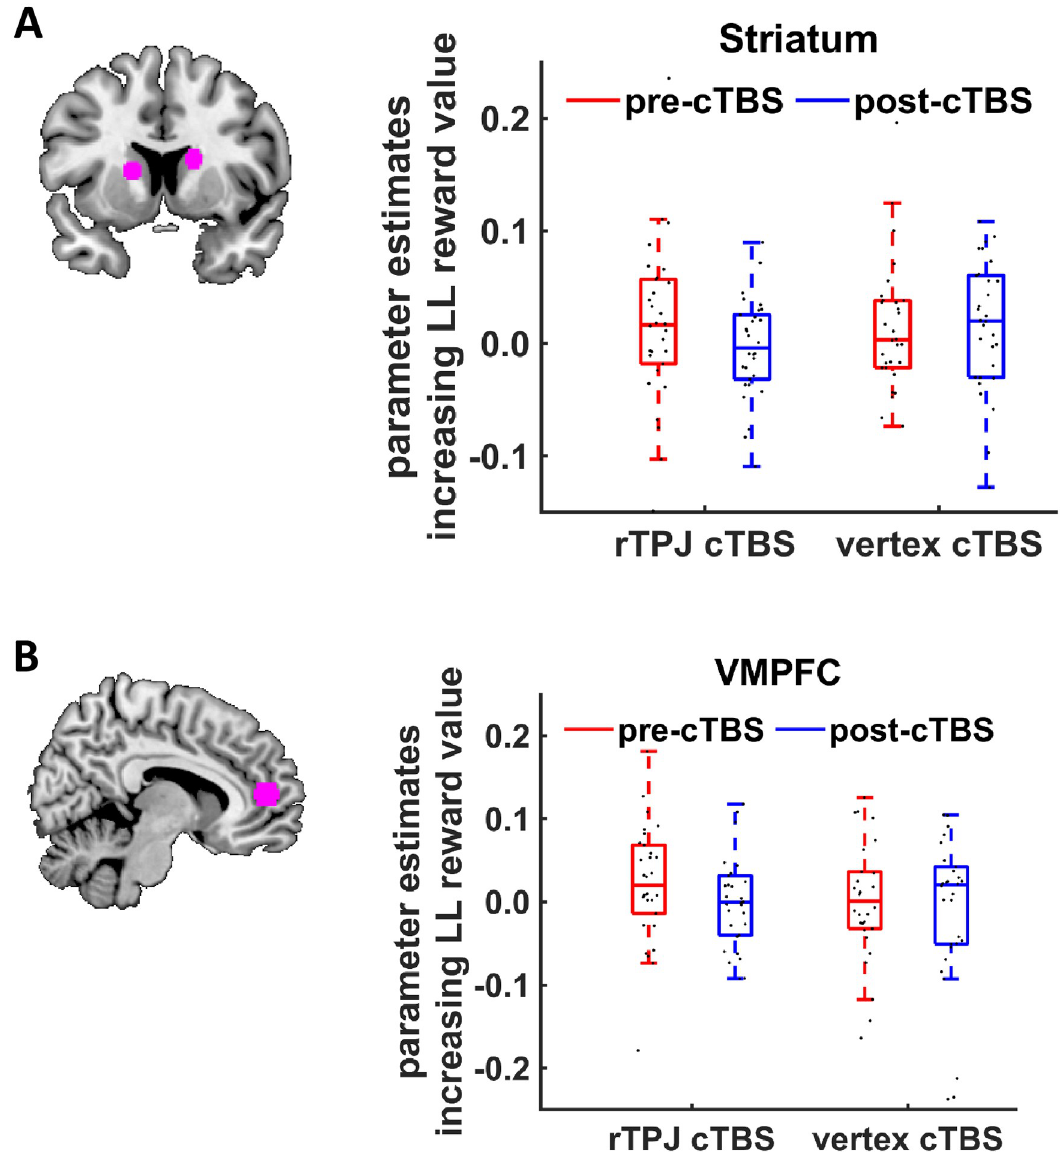
Fig 4. Neural encoding of delayed (future) reward value in the intertemporal decision task. Illustration of ROIs for (A) striatum and (B) VMPFC based on [31]. We observed no cTBS effects on value-related striatum or VMPFC activation. Boxes indicate median (in red) and interquartile range. Black dots show individual parameter estimates. The underlying data for this Figure can be found in S1 Data. cTBS, continuous theta-burst stimulation; LL, larger-later; ROI, region of interest; VMPFC, ventromedial prefrontal